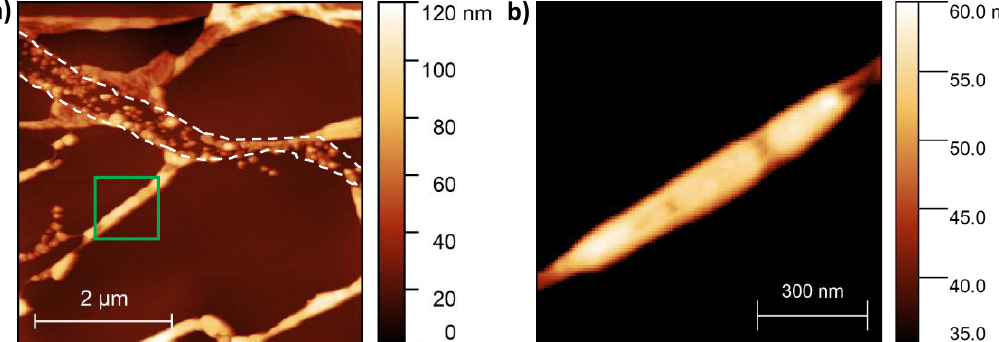
Figure 2. ( a ) AFM image of graphene-covered Ag nanostructures formed on HOPG substrate during annealing at 400 °C. Bare nanoparticles are also observed between the two white dashed lines, which mark a discontinuity of the graphene overlayer. ( b ) Larger magnification of AFM image corresponding to the square marked with green lines in ( a ), showing graphene–Ag NP–HOPG sandwich structure.